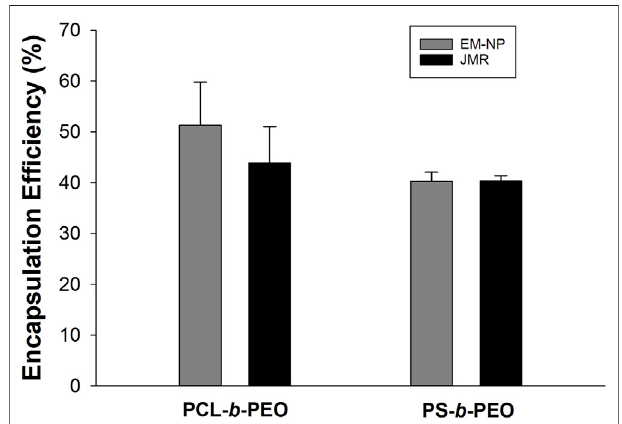
FIGURE 6 | EM-NP vs. FNP JMR Coumarin 6 encapsulation ef fi ciency (%) in PS- b -PEO and PCL- b -PEO nanocarriers. Error bars (cid:1) standard deviation from mean. Number of experimental runs at each data point, n (cid:1) 2. No statistical differences were detected between EM-NP and JMR samples or between polymer